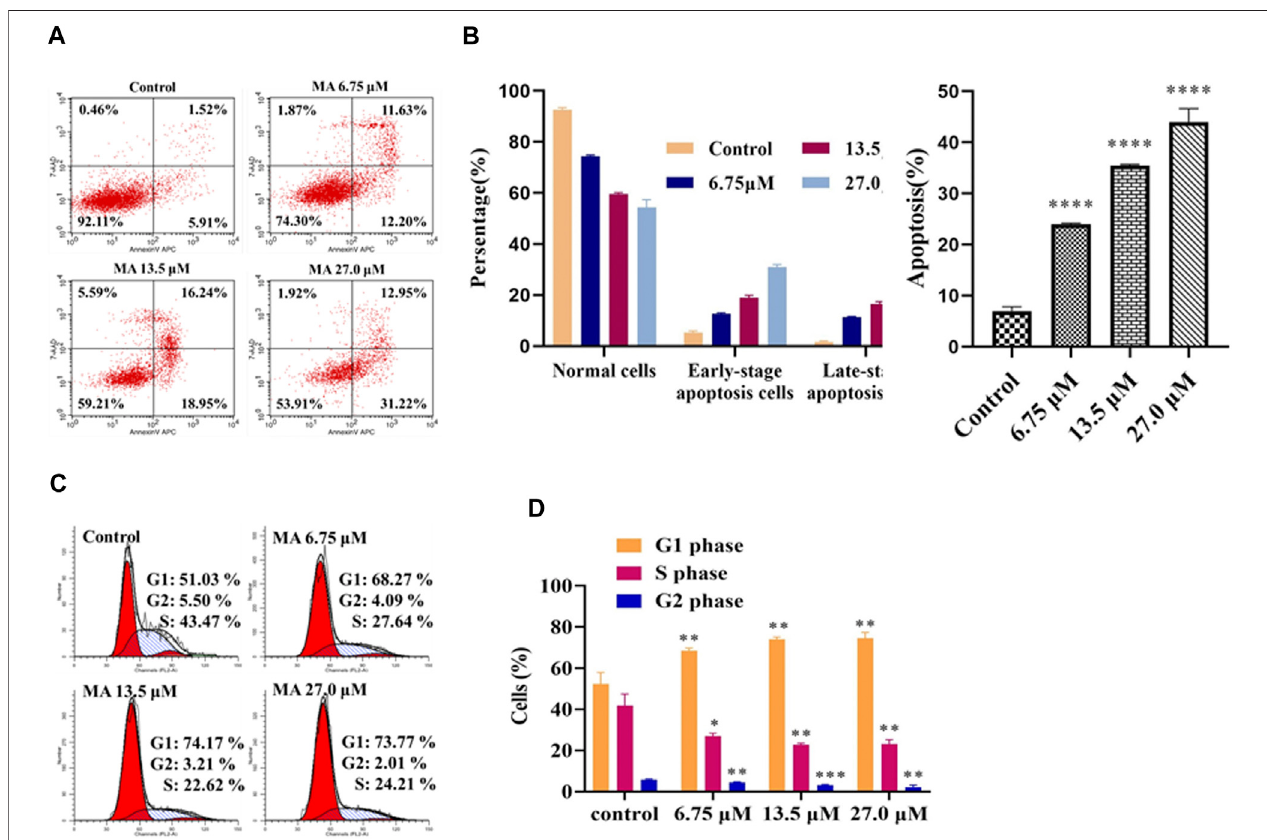
FIGURE 3 | MA enhanced the apoptotic process of HeLa cells and stimulated cell cycle arrest of HeLa cells in G0/G1 phase. (A) Apoptotic pro fi le of cells treated with different concentrations of MA by Flow cytometer (Annexin-V APC/7-AAD). Upper left quadrant, naked nucleus cell; upper right quadrant, late apoptosis or necroticcells; lowerleft quadrant,livingcells; lowerright quadrant,earlyapoptoticcell. (B) Thequantitativeanalysisoftheproportionofapoptosiswascarriedout. (C) Cell cycle distribution (left red, right red, oblique line, and white part indicate G1 phase cell, G2 phase cells, S phase cells, and total cells, accordingly). (D) The quantitative analysis of different phases has been indicated. The results obtained from triplicate experiments (independent) were represented as mean ± SD (relative to the control group, * p < 0.05, ** p < 0.01, *** p < 0.001, **** p < 0.0001).